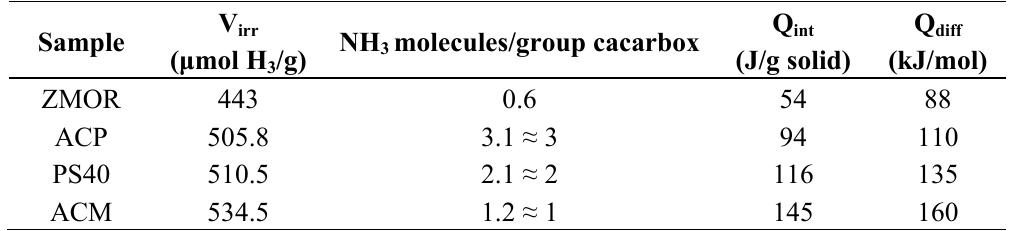
Table 3. Quantitative (number of moles per gram of porous solid; number of molecules per cation) and energetic data (integral heat of adsorption per gram of porous solid and initial differential heat of adsorption) on the adsorption of NH this